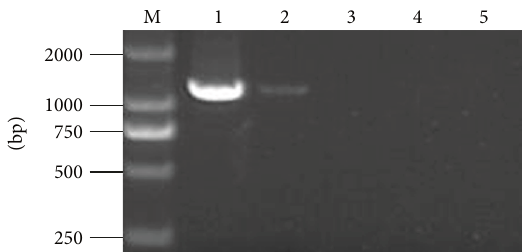
Figure 2: Phytoplasma 16S rDNA amplication in DMS-treated P. fortunei . (M) DNA marker. (1) PFI. (2) PFI-15. (3) PFI-75. (4) PF. (5) ddH 2